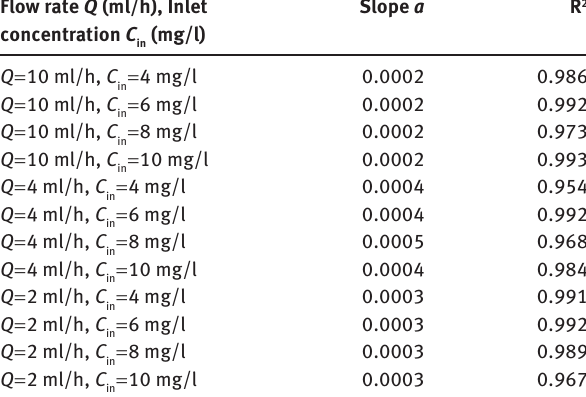
Table 2 Parameters obtained from the linear fit X = a ( wL / h 2 ). The linear fits are performed with the data from Figure 6 . R 2 is the regression